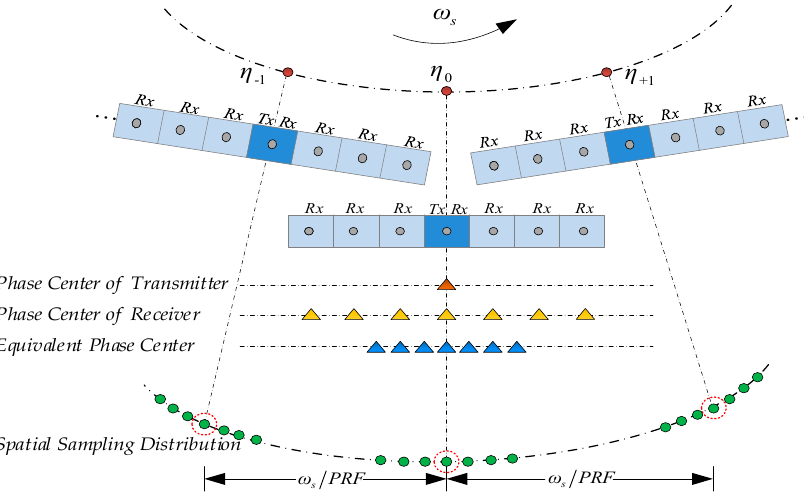
Figure 2. Azimuth multichannel sampling for hypersonic platform SAR.